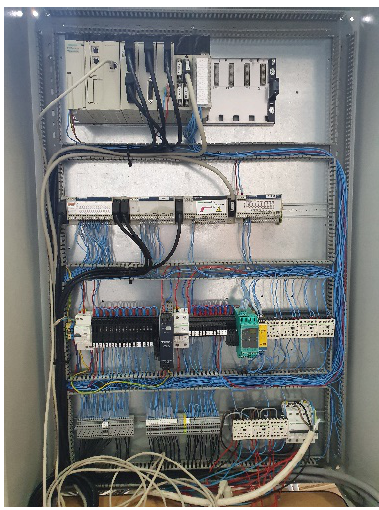
Figure 13. Automation panel.